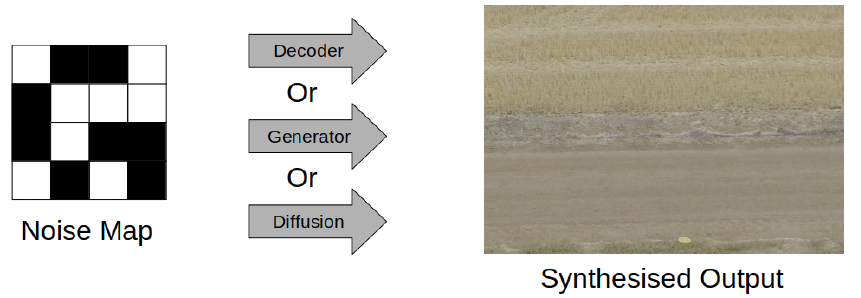
Figure 4. Synthesis via processing of noise